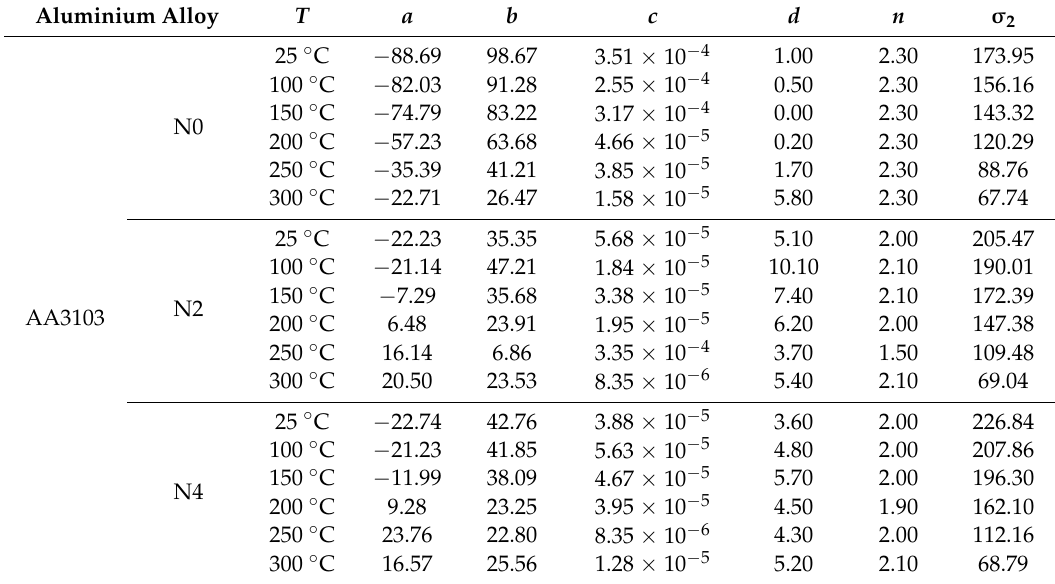
Table 2. Values of the parameters for the new flow rule proposed for AA3103.